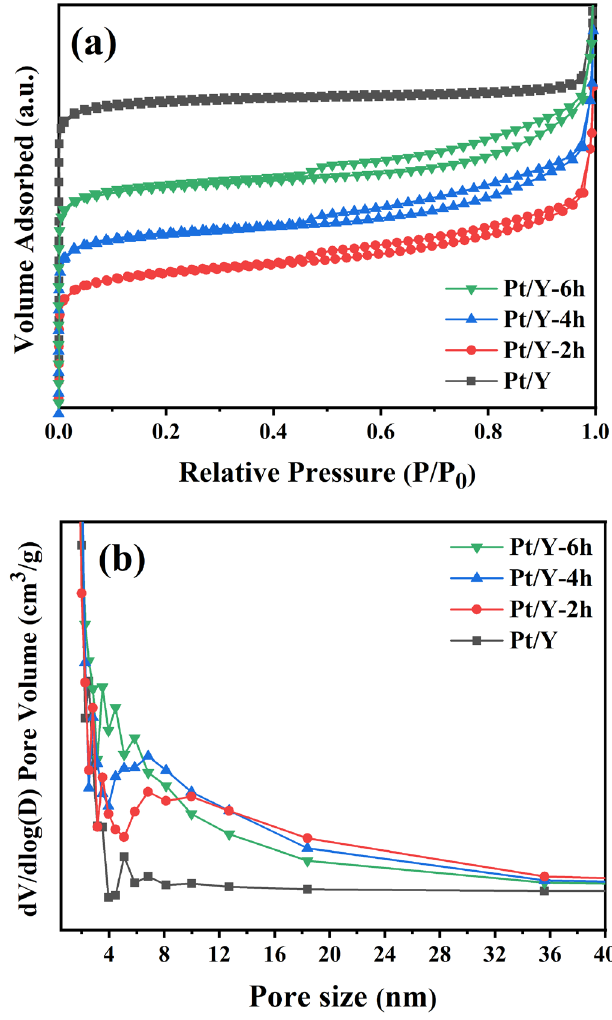
Figure Figure 2. ( a ) N 2 adsorption–desorption and ( b ) pore size distribution according to the Bar- rett−Joyner−Halenda (BJH) curves of the Pt/Y zeolites.